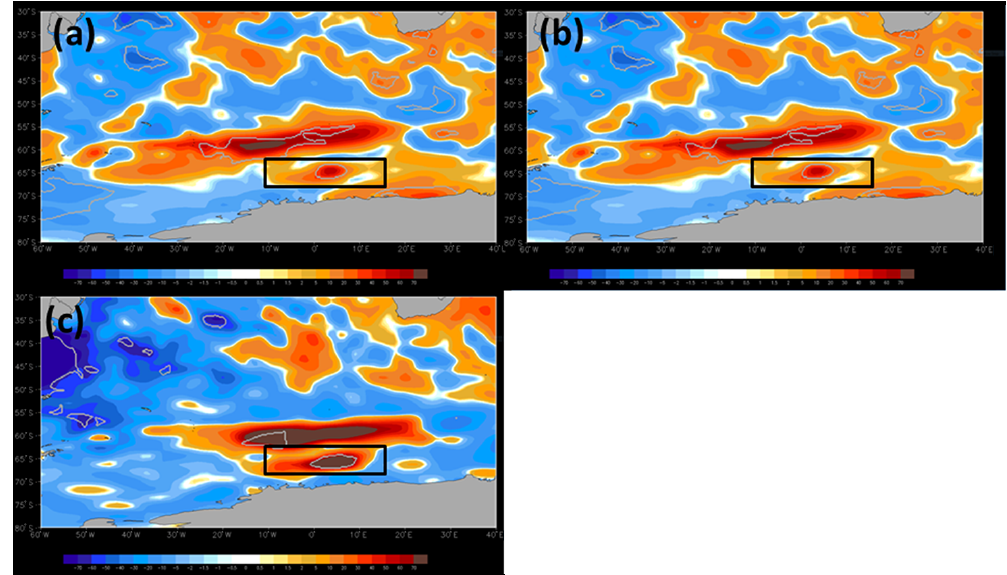
Figure 7. Monthly anomalies of net shortwave radiation (Wm − 2 ) for (a) September, (b) October, and (c) November 2017 in the Maud Rise polynya (black rectangles). The anomalies were computed relative to a 38-year climatology (1979–2016). The regions within grey polylines show the record level shortwave radiation in 2017 that lies outside of values from 1979 to 2016.